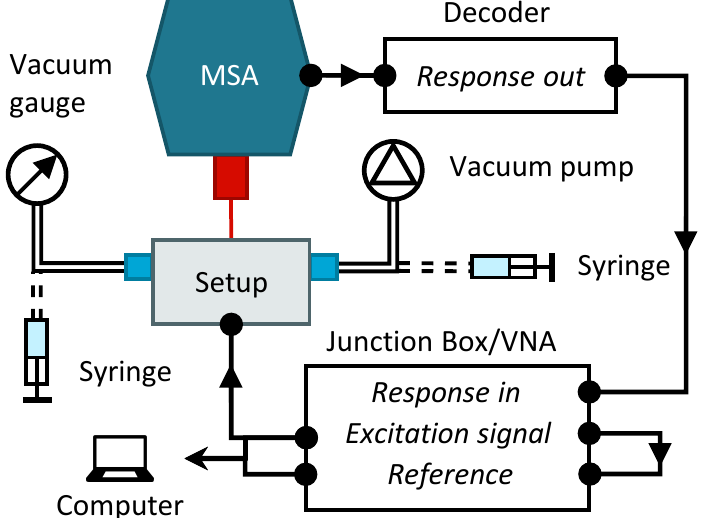
Figure 5. Schematic of experimental setup and auxiliary components. The arrows indicate the data acquisition path. The dotted tubing indicates the option of connecting either the vacuum components or the syringes for liquid